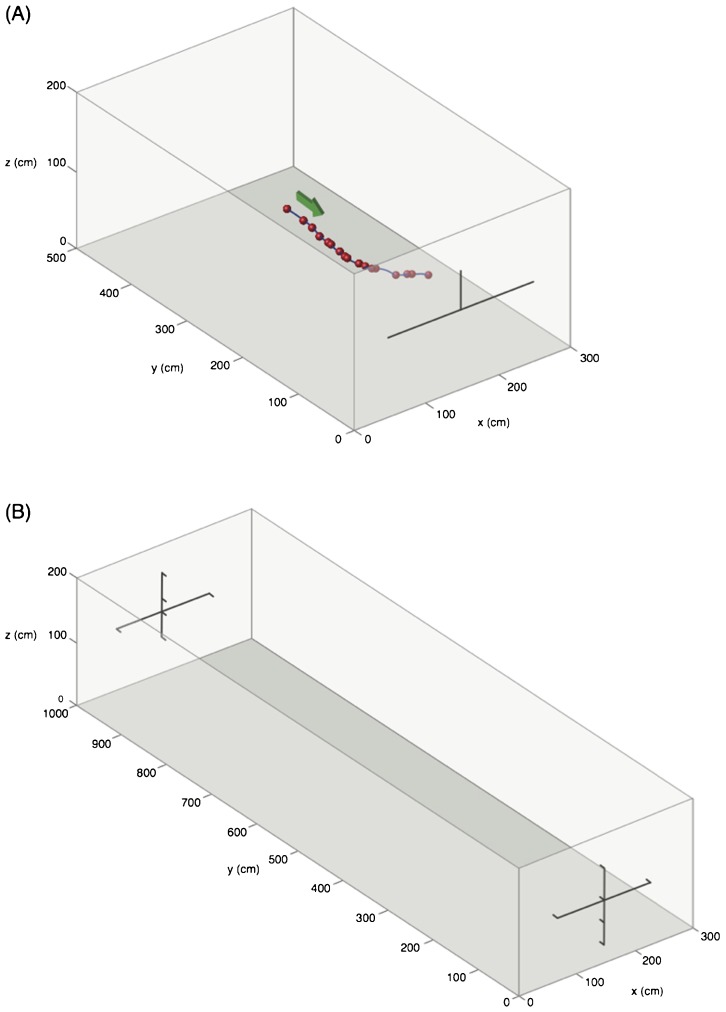
Flight rooms.(A) Small flight room (length 5 m × width 3 m × height 2 m) with flight path of a single R. capensis and (B) large flight room (length 10 m × width 3 m × height 2 m).